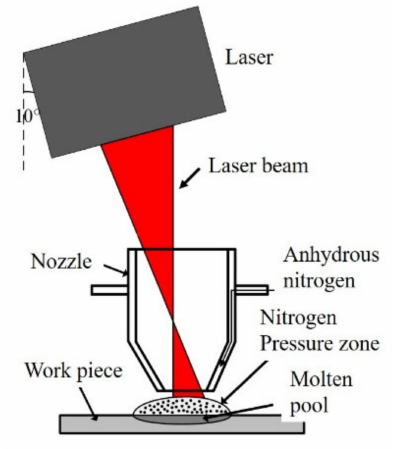
Figure 1. Schematic diagram of the laser gas nitriding